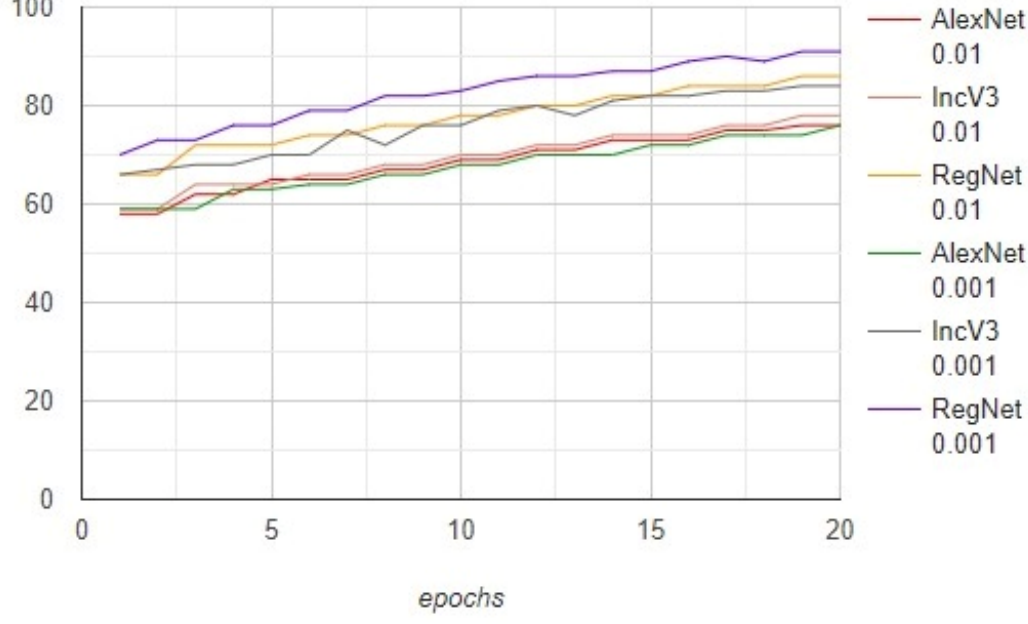
Figure 6. The performance of the proposed framework based on the accuracy.